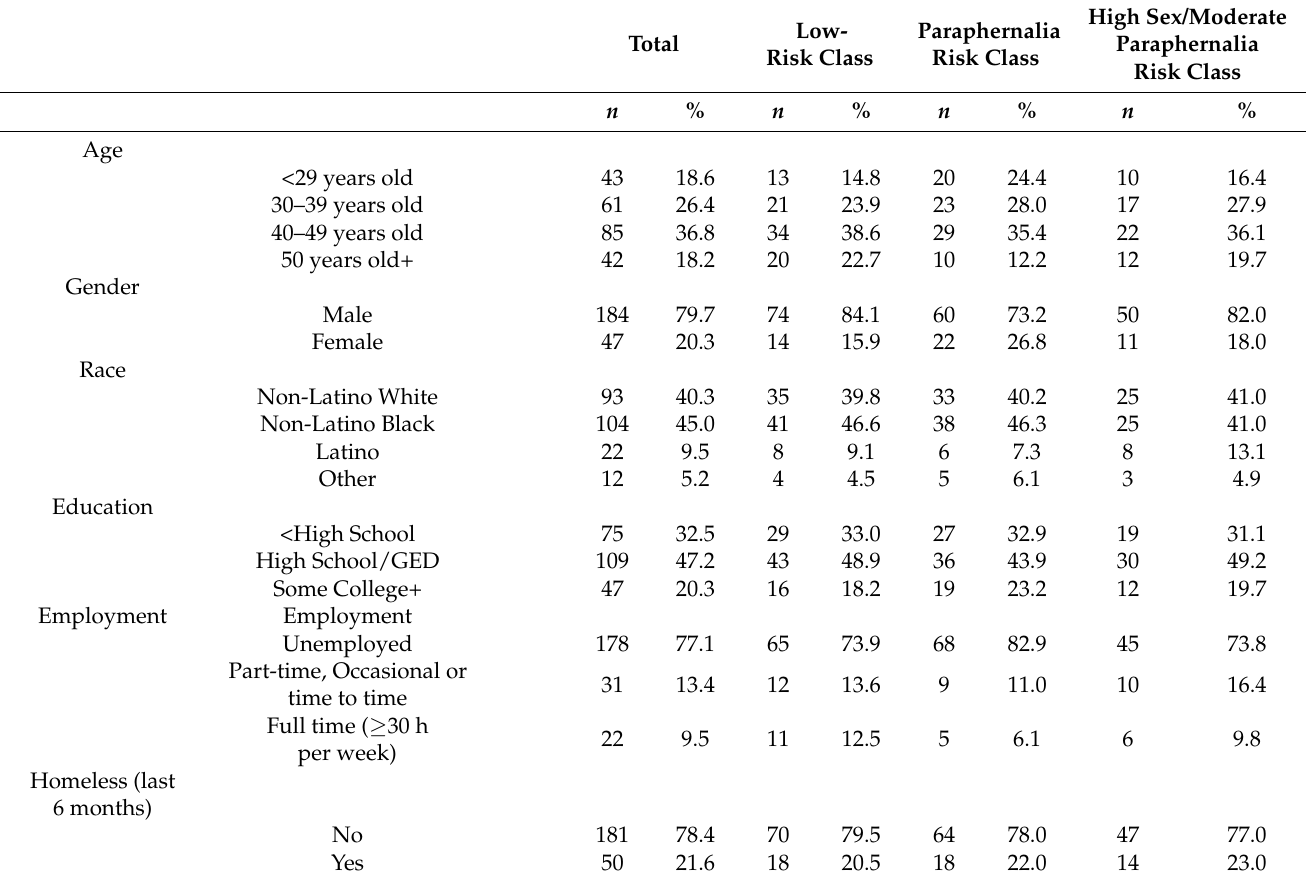
Table 1. Demographic characteristics of index participants ( n = 232) by latent